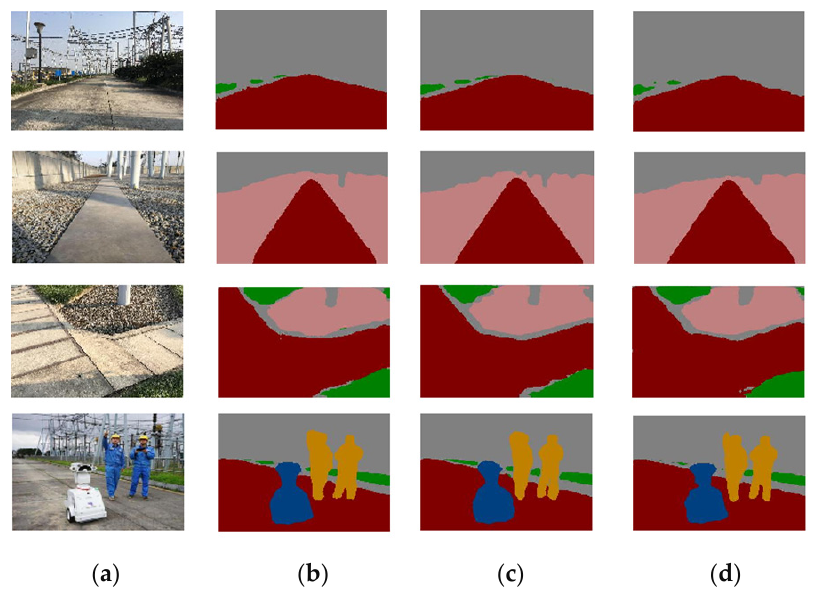
Figure 10. Network detection effect before and after improvement: ( a ) original diagram of substation; ( b ) DeepLab V3+; ( c ) improved DeepLab V3+; ( d ) improved DeepLab V3+(clipping).